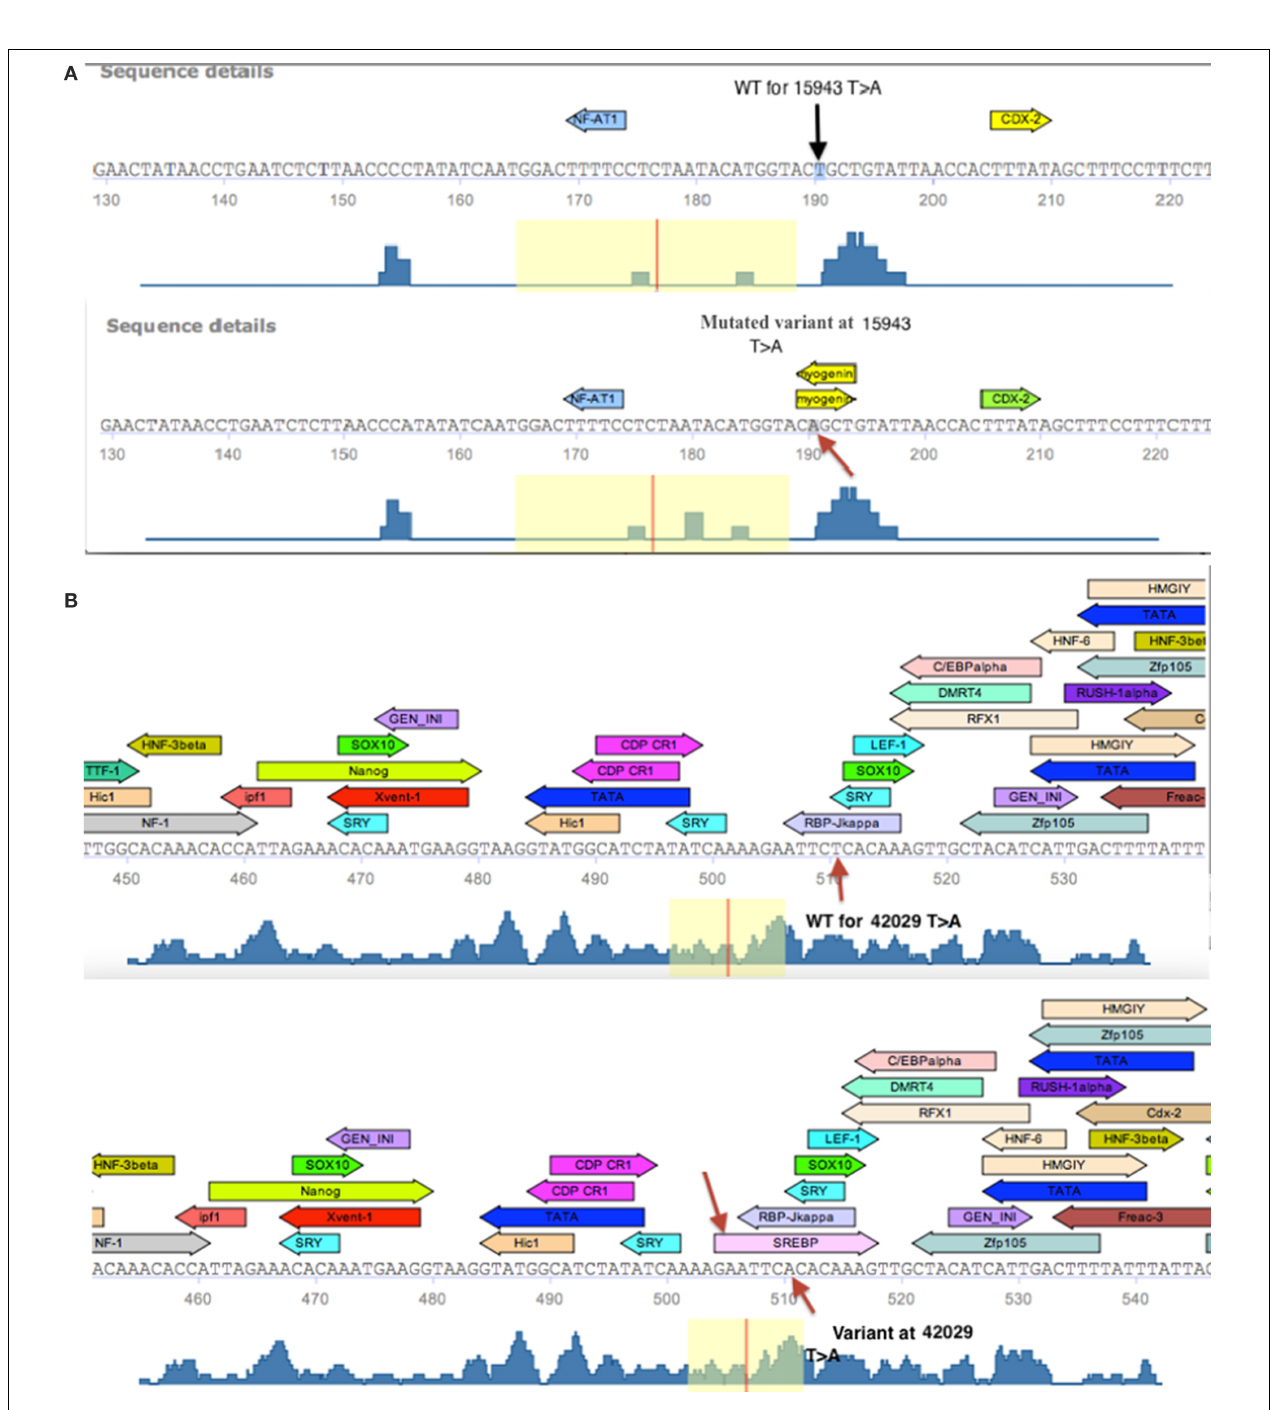
FIGURE 3 | Schematic diagram of the Transfac predicted TF binding sites within a fragment of LATS1 gene. (A) Transfac diagram of the wild type (WT) fragment of LATS1 intron-1 that depicts the myogenin transcription factor-binding site as created by the variant at consensus